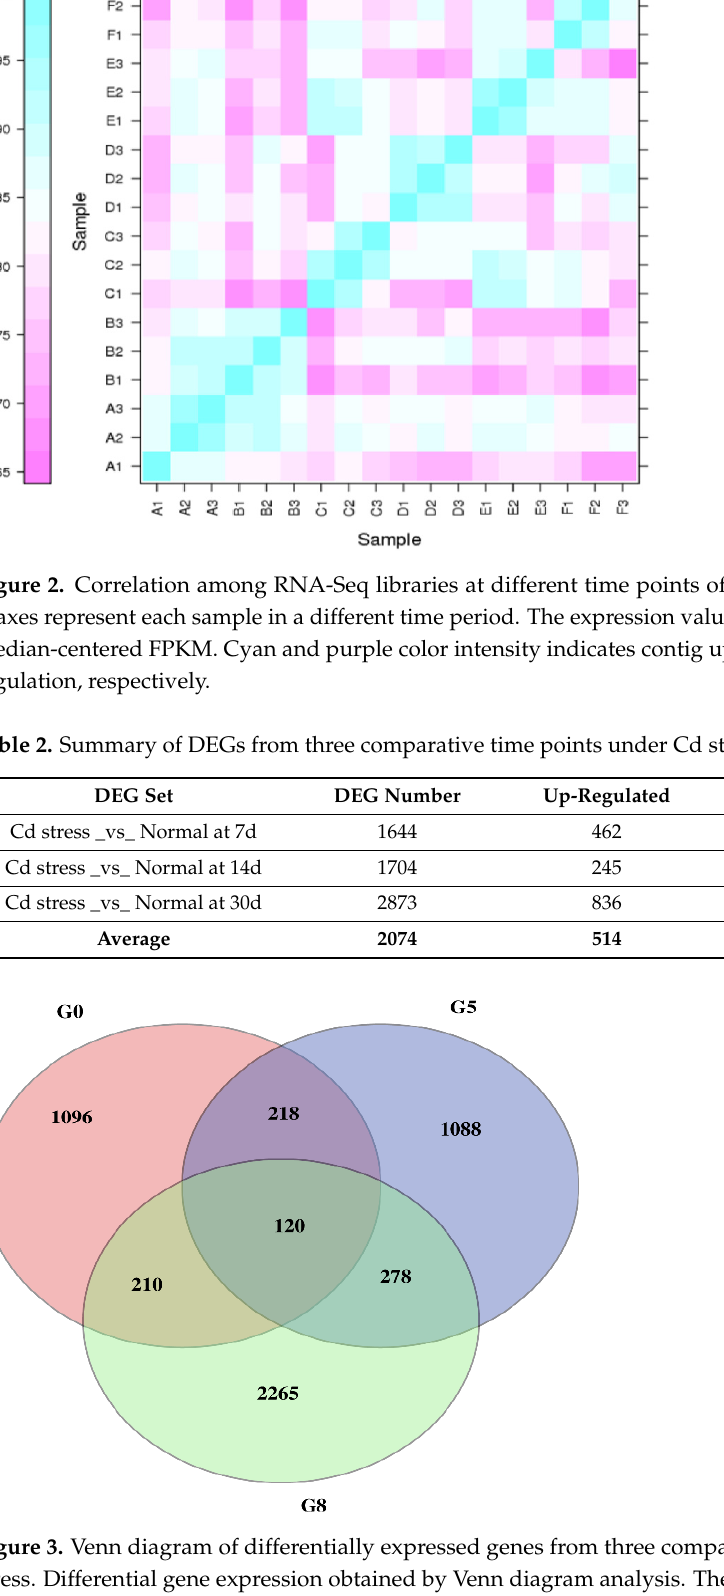
Table 2. Summary of DEGs from three comparative time points under Cd stress.